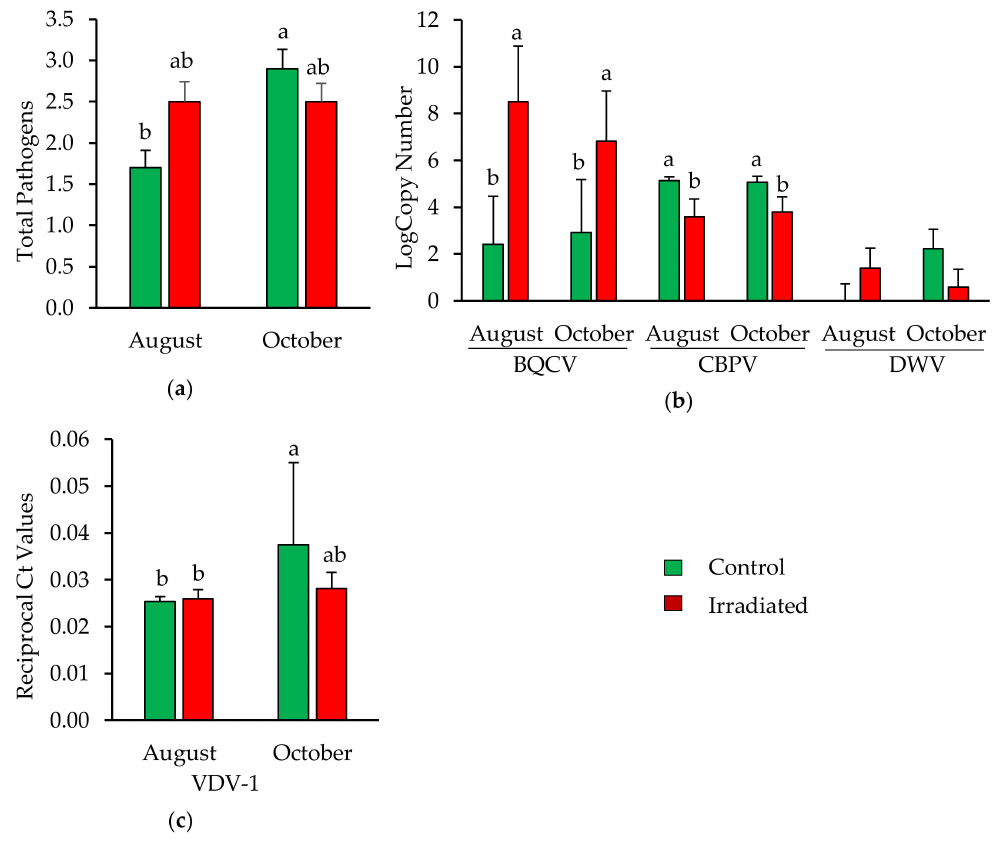
Figure 6. Pathogen loads for newly emerged bees from colonies having irradiated or non-irradiated (control) combs in August and October 2016: ( a ) Total number (mean ± SE) of pathogens detected; ( b ) levels (mean ± SE) of Black queen cell virus (BQCV), CBPV and Deformed wing virus (DWV); and ( c ) VDV-1. Bars without letters are not significantly different ( p >